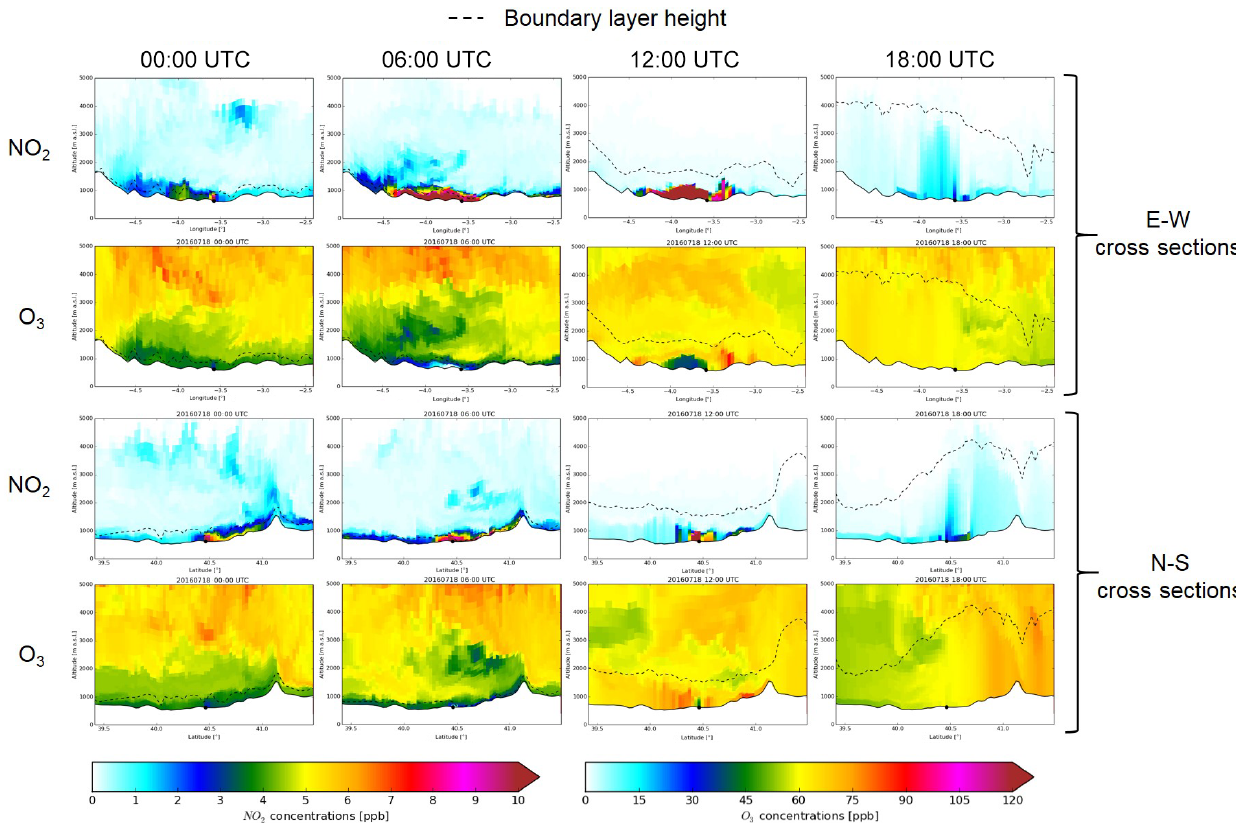
Figure 10. Simulated longitudinal and latitudinal vertical cross sections of NO 2 and O 3 for 18 July 2016 (WRF_70 run). See Fig. 1 to consult the latitudinal and longitudinal